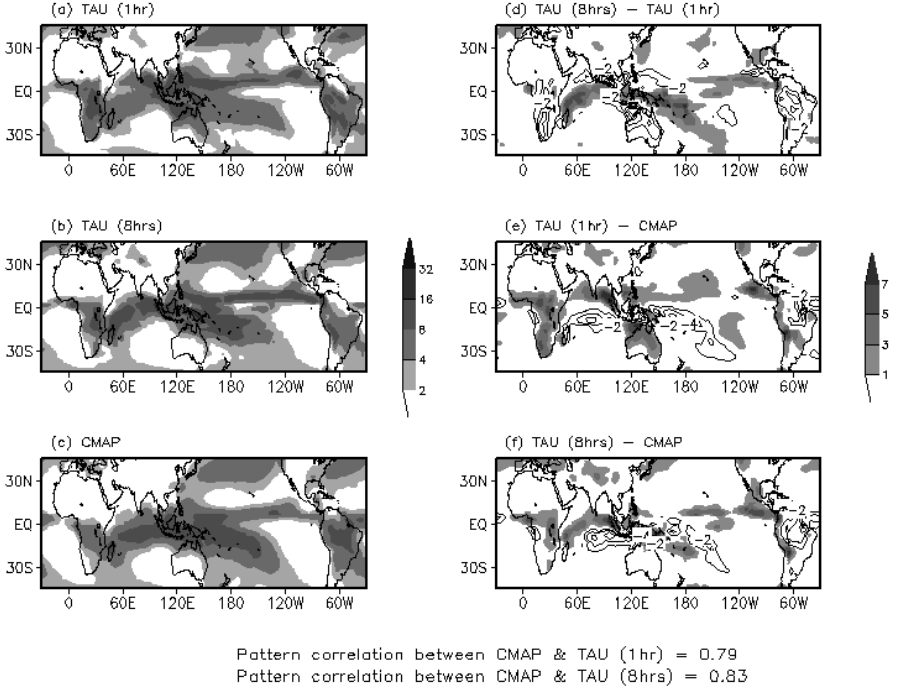
Fig. 21. Climatological mean DJF precipitation (mm/day) for (a) TAU (1h), (b) TAU (8h), (c) CMAP, (d) [TAU (8h) – TAU (1h)], (e) [TAU